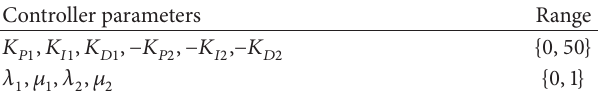
Table 4: Range of controller parameters. Controller